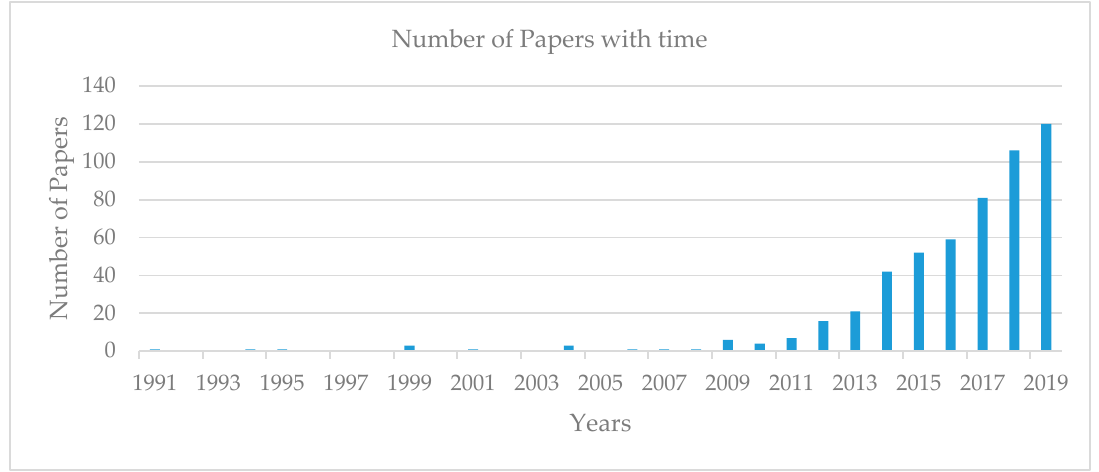
Figure 1. Web of Science ® bibliometric study with topics “anaerobic digestion” and “rice straw” from 1991 until December 2019. The number of publications from 1991 to 1999 was 6; from 2000 to 2008 was 7; and from 2009 to 2019 was 512.